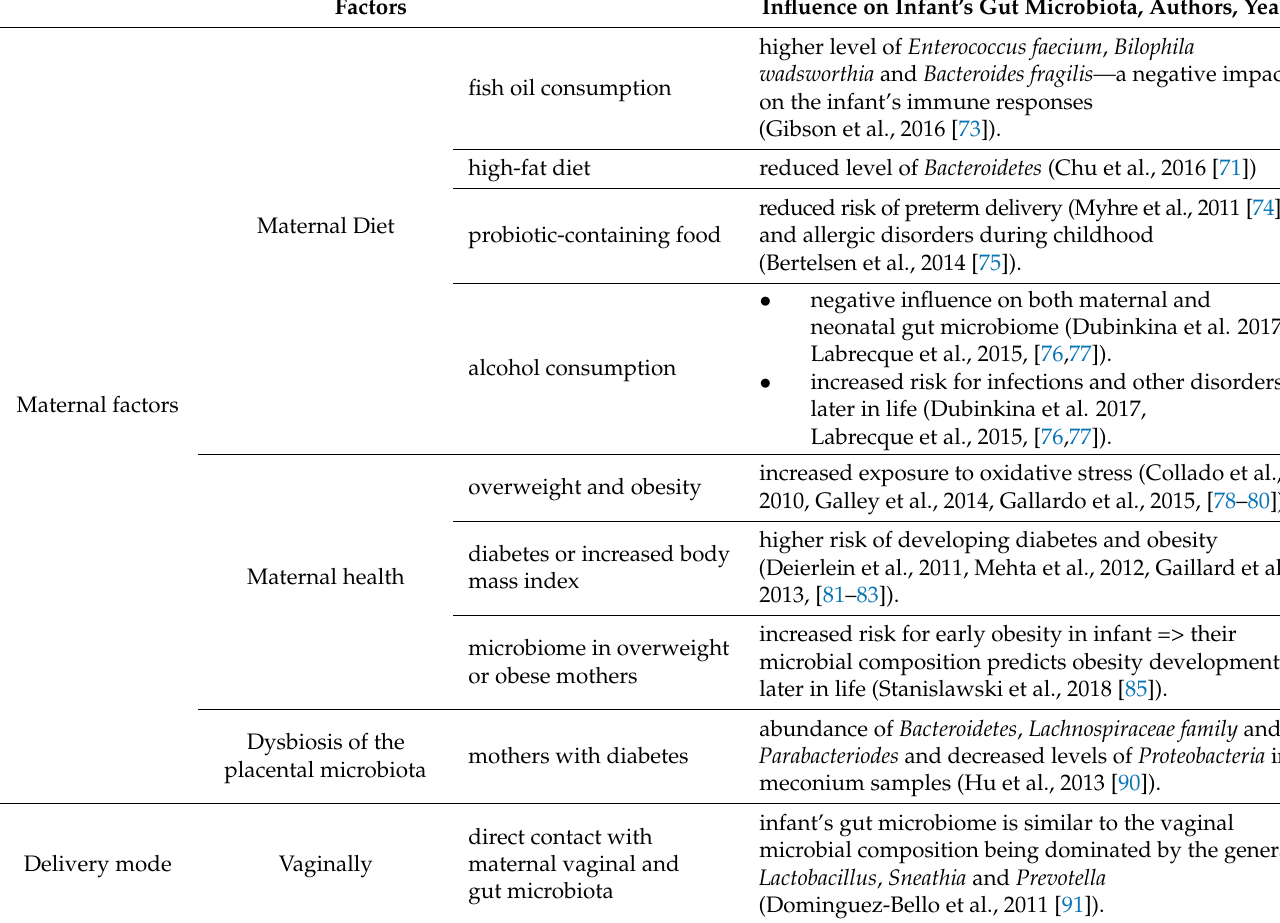
Table 1. The factors influencing gut microbiome in children with